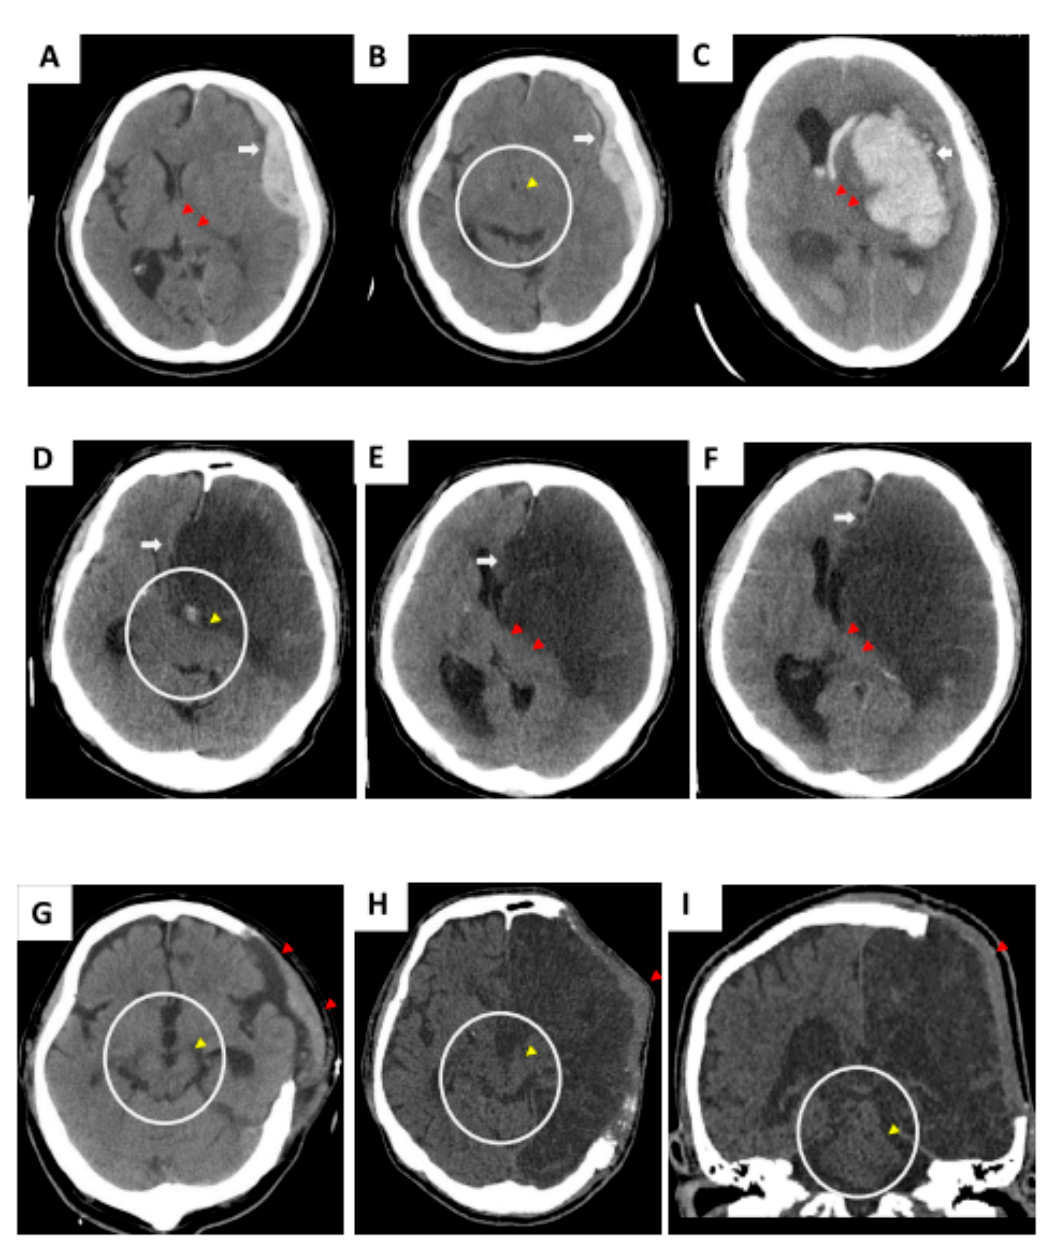
Figure 1. Initial computed tomography (CT) scan showing compromised brainstem due to acute subdural hematoma (SDH) ( A , B , case 1), hemorrhagic stroke ( C , case 2), and malignant cerebral infarction ( D – F , case 3). Alteration of brainstem shape was caused by intracranial mass effect. Wide decompressive craniectomy (DC) should be performed immediately to create extensive volume, which accommodates postoperative brain swelling. ( G – I ) Brainstem shape was morphologically